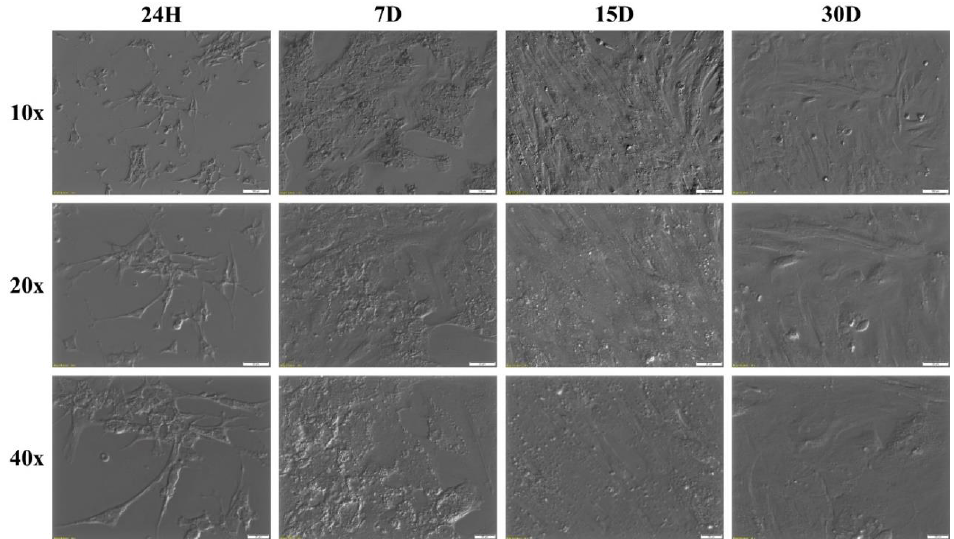
Figure 6. Change in granulosa cell (GC) morphology during long-term in vitro primary culture. 24H: first day of culture; D: day of culture; 10 × , 20 × , 40 × : magnification.